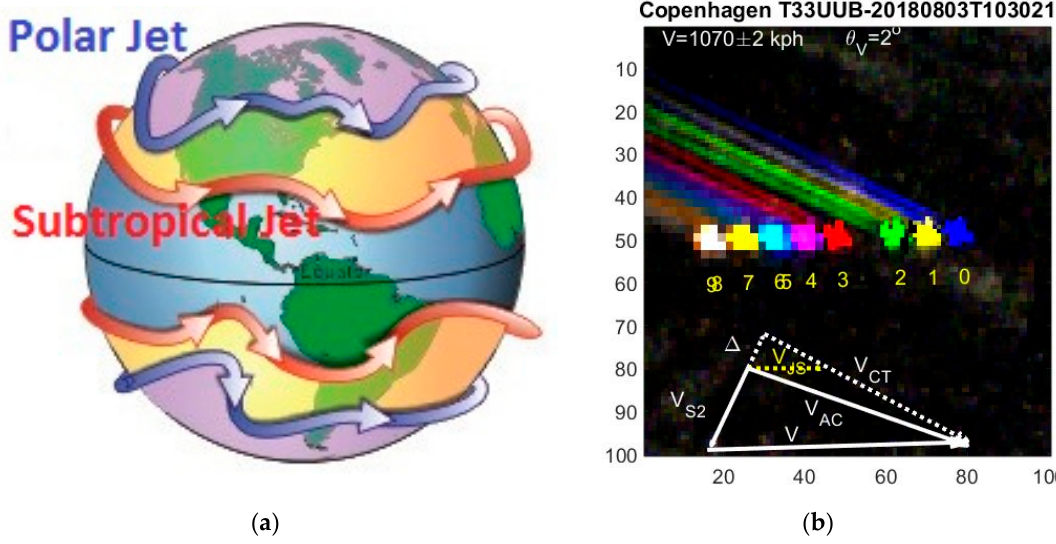
Figure 5. ( a ) Illustration of Earth’s meandering polar and subtropical jet streams. ( b ) An aircraft over Copenhagen where the contrails are affected by the polar jet stream (see text).